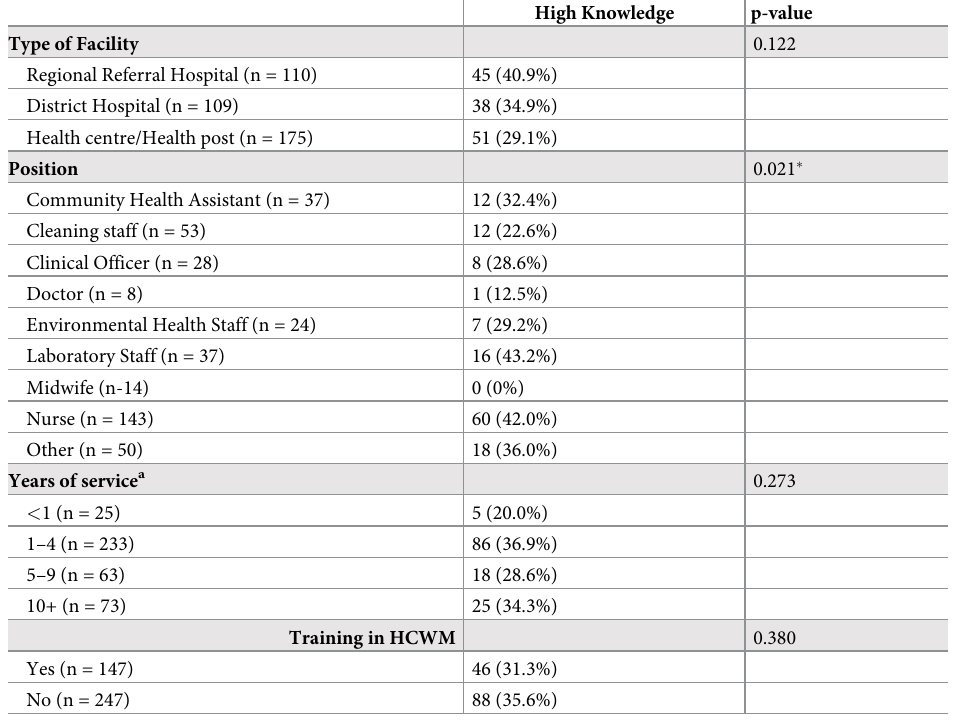
Table 3. Waste segregation knowledge by facility type, job position, years of service, and prior training in health care waste management.